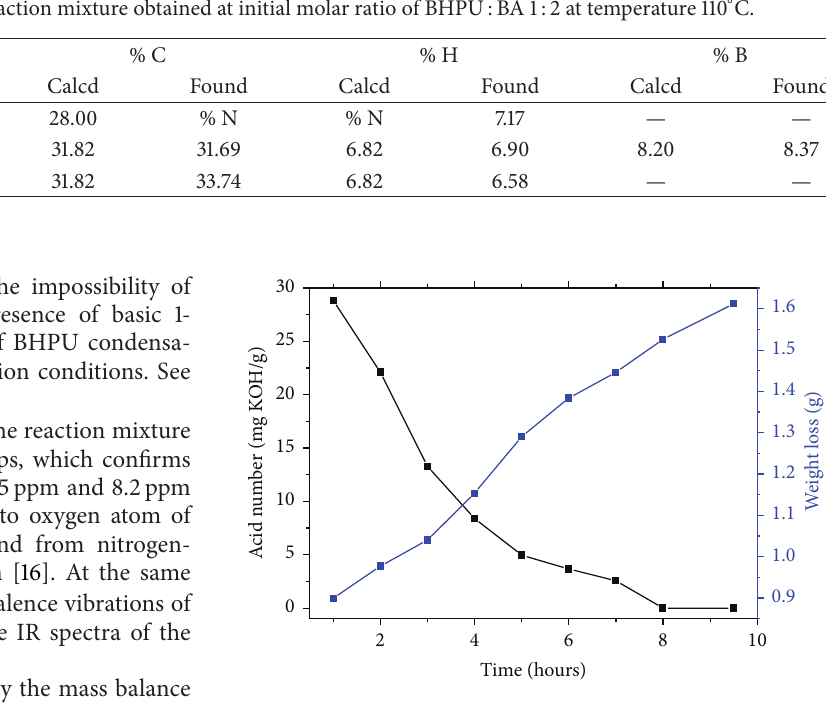
Figure 1: Weight loss and AN changes of BHPU and BA mixed at the molar ratio 1: 2 during reaction at temperature 110 ∘ C.